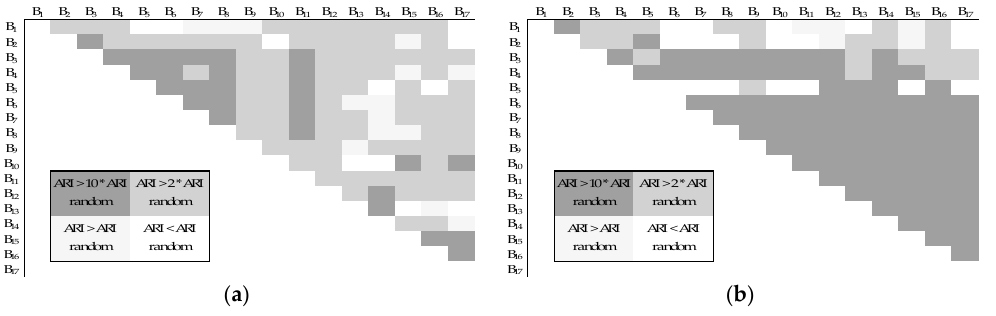
Figure 7. The Adjusted Rand Index (ARI) results for 𝑚𝑖𝑛𝑆𝑒𝑟𝑖𝑒𝑠 set at 5% and window length w set at 30 days (short-term version is presented on the left part ( a ) while long-term on the right part of the figure ( b )).